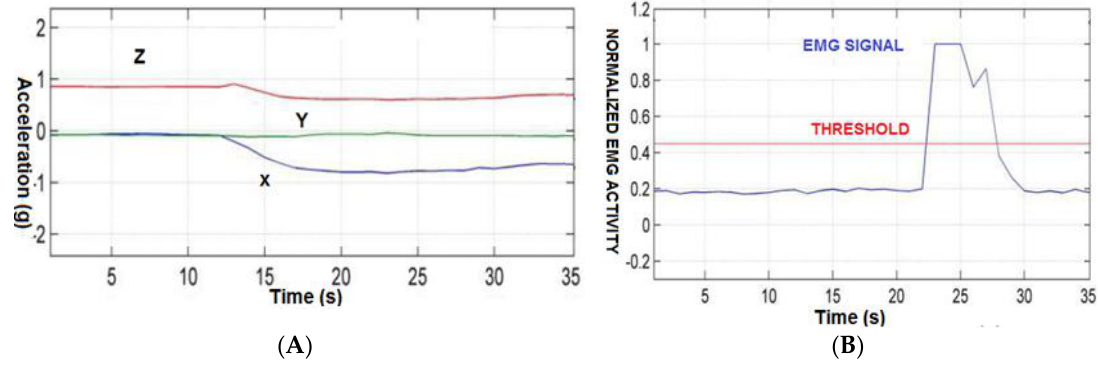
Figure 6. Example response of ( A ) the 3-axis accelerometer; ( B ) the acquired EMG sensor signal.